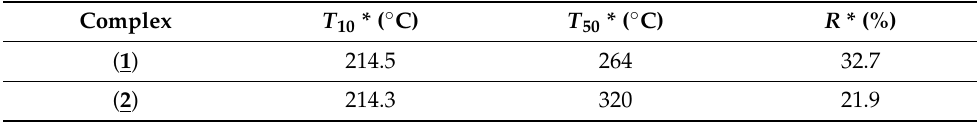
Table 10. Results of thermal decomposition of the two compounds.